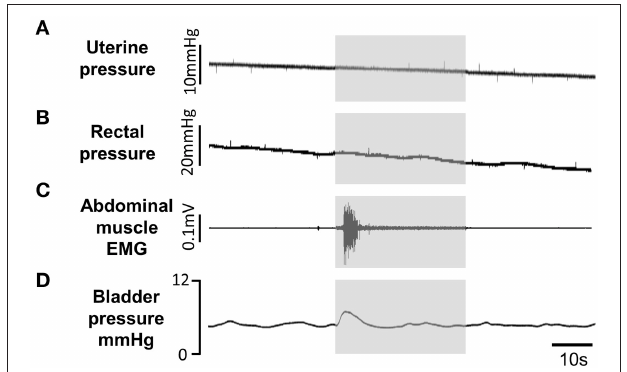
FIGURE 9 | Off-target effects of pelvic nerve stimulation (gray panels) using Stimulation optimal for inhibiting voiding (3 kHz 1 mA sinusoidal waveform) had no effect on uterine (A) or rectal (B) pressure. A transient contraction of abdominal wall (C) was evoked at stimulus onset. Pelvic nerve stimulation between voids evoked only small transient rise in bladder pressure (D) at the onset of stimulation. All traces from the same